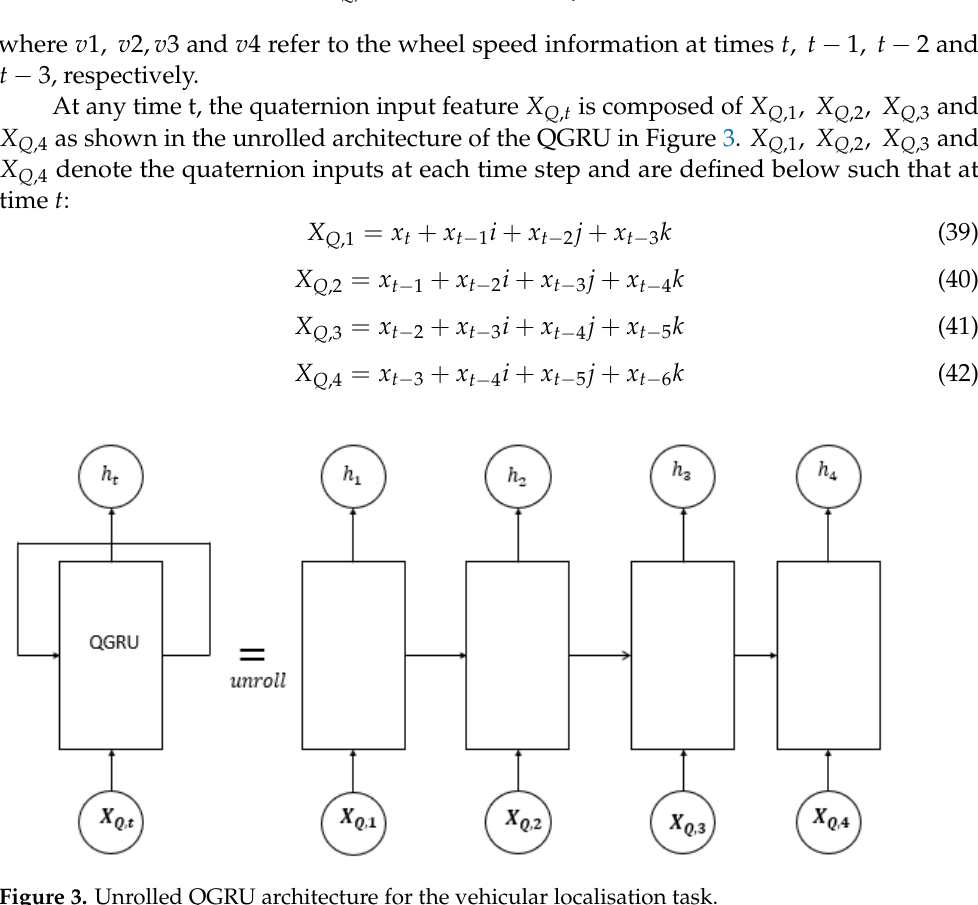
Figure 3. Unrolled QGRU architecture for the vehicular localisation